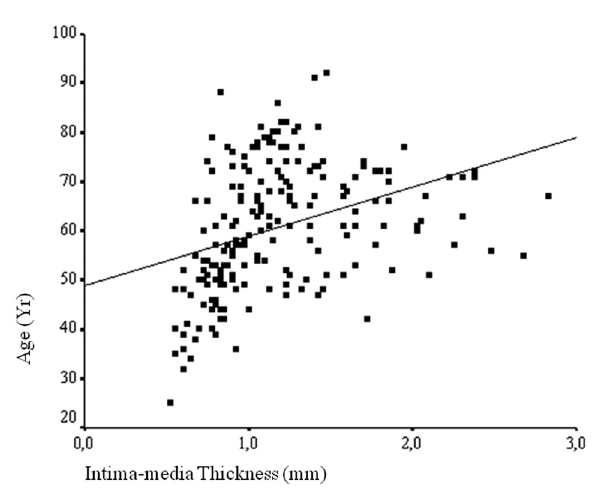
Figure 1 - Correlation between increasing age and mean bilateral carotid wall intima-media